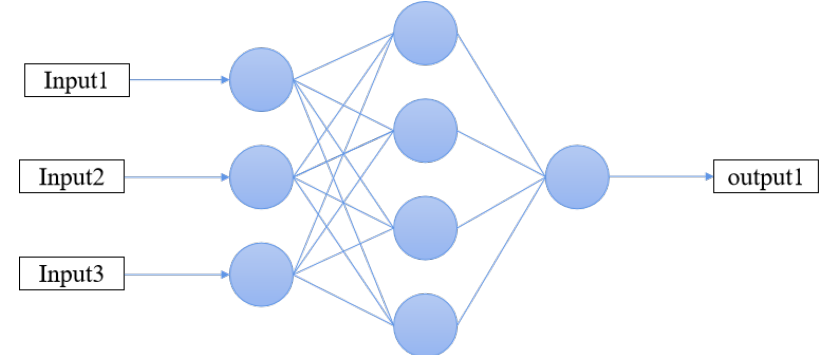
Figure 6. Structure diagram of the BP neural network.